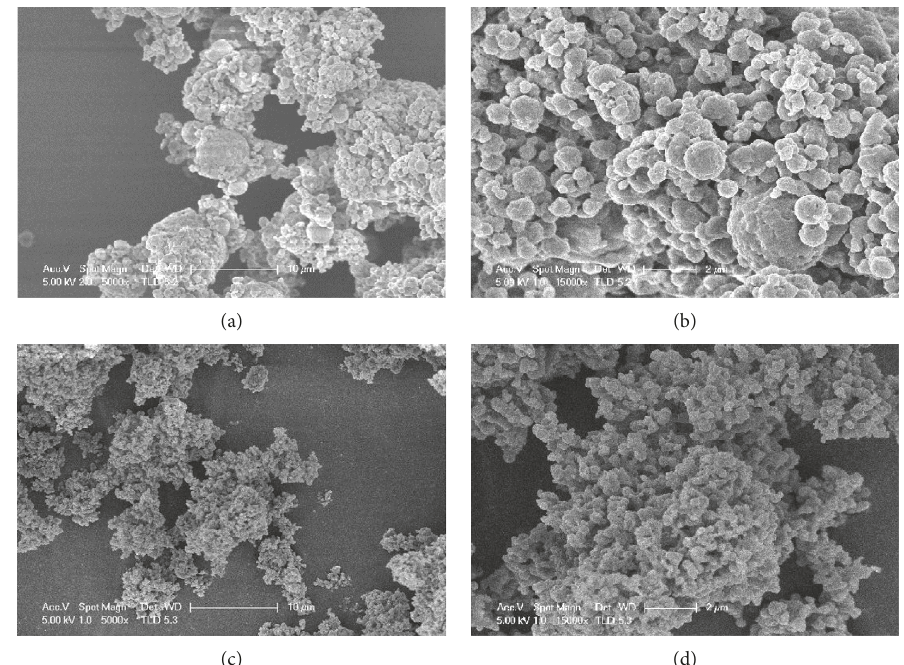
Figure 4: SEM images of fraction 1 dried by solvent exchange (a, b) and fraction 2 also dried by solvent exchange (c, d) at two different